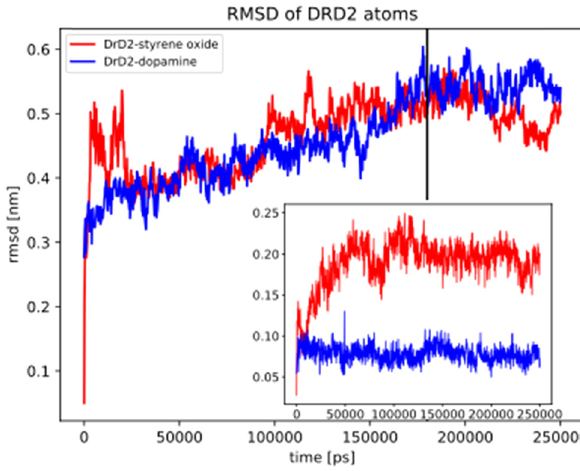
Figure 5: RMSD of the DrD2 C α atoms for the two systems, computed in the NpT ensemble at T = 300 K. The black vertical line marks the